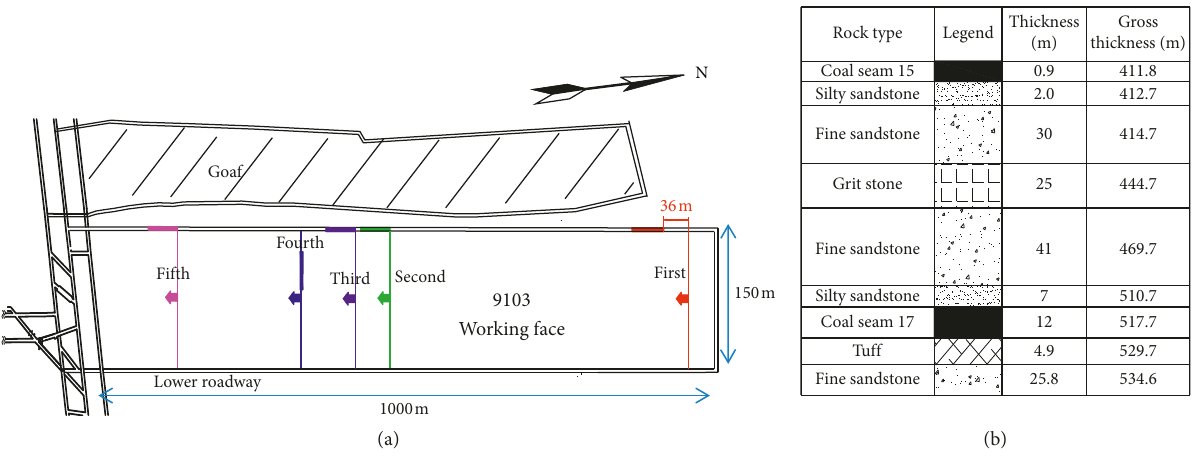
Figure 2: Geological and mining condition of selected panel.